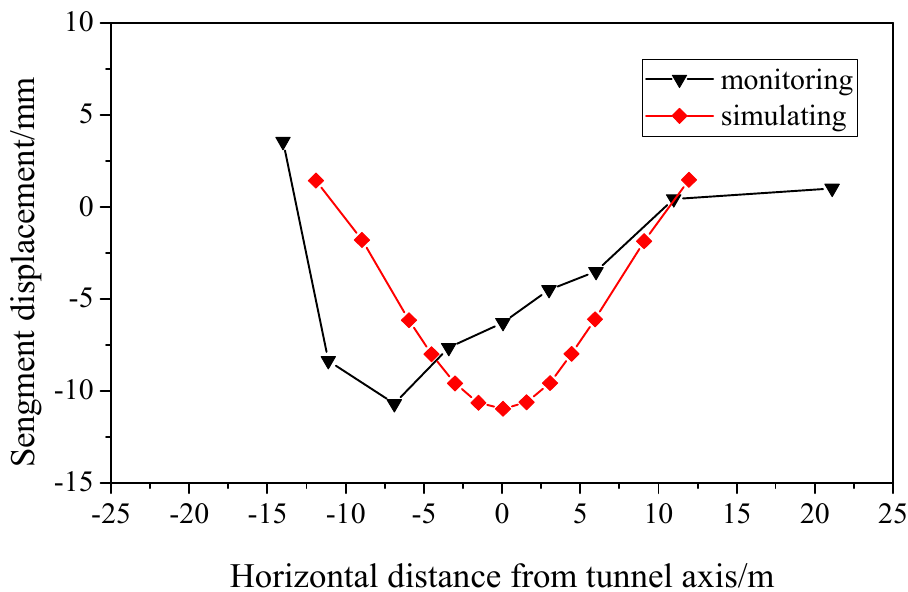
Horizontal distance from tunnel axis/m Figure 8. Simulated and monitored surface subsidence trough. Figure 8. Schematic diagram of shield tunnel excavation.